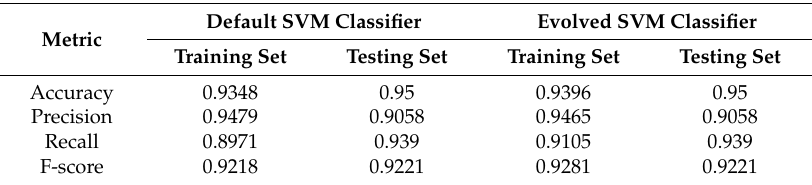
Table 11. Performance of SVM classifiers on training and testing sets.